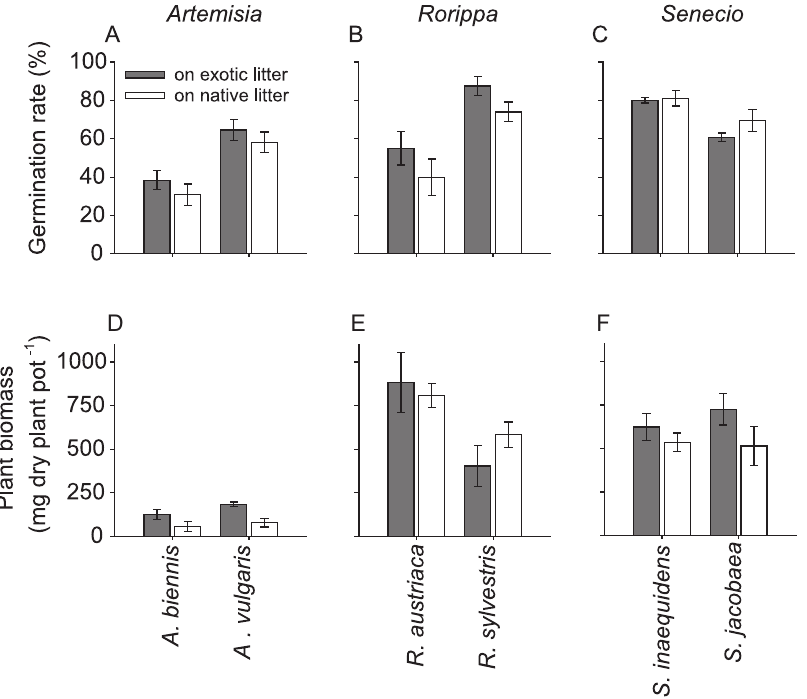
Figure 3. Effects of litter on germination rates and plant biomass production. Mean ( 6 SE) for germination or (in the case of Rorippa ) sprouting rate (A, B, C) and plant biomass (D, E, F) production of exotic and native plant species in litter from exotic (grey bars) or native plant species (white bars) belonging to three genera. Exotic plant species are: A. biennis, R. austriaca and S. inaequidens . Native plant species are: A. vulgaris, R. sylvestris and S. jacobaea . Significances of litter effects and plant effects are given in Table 4.